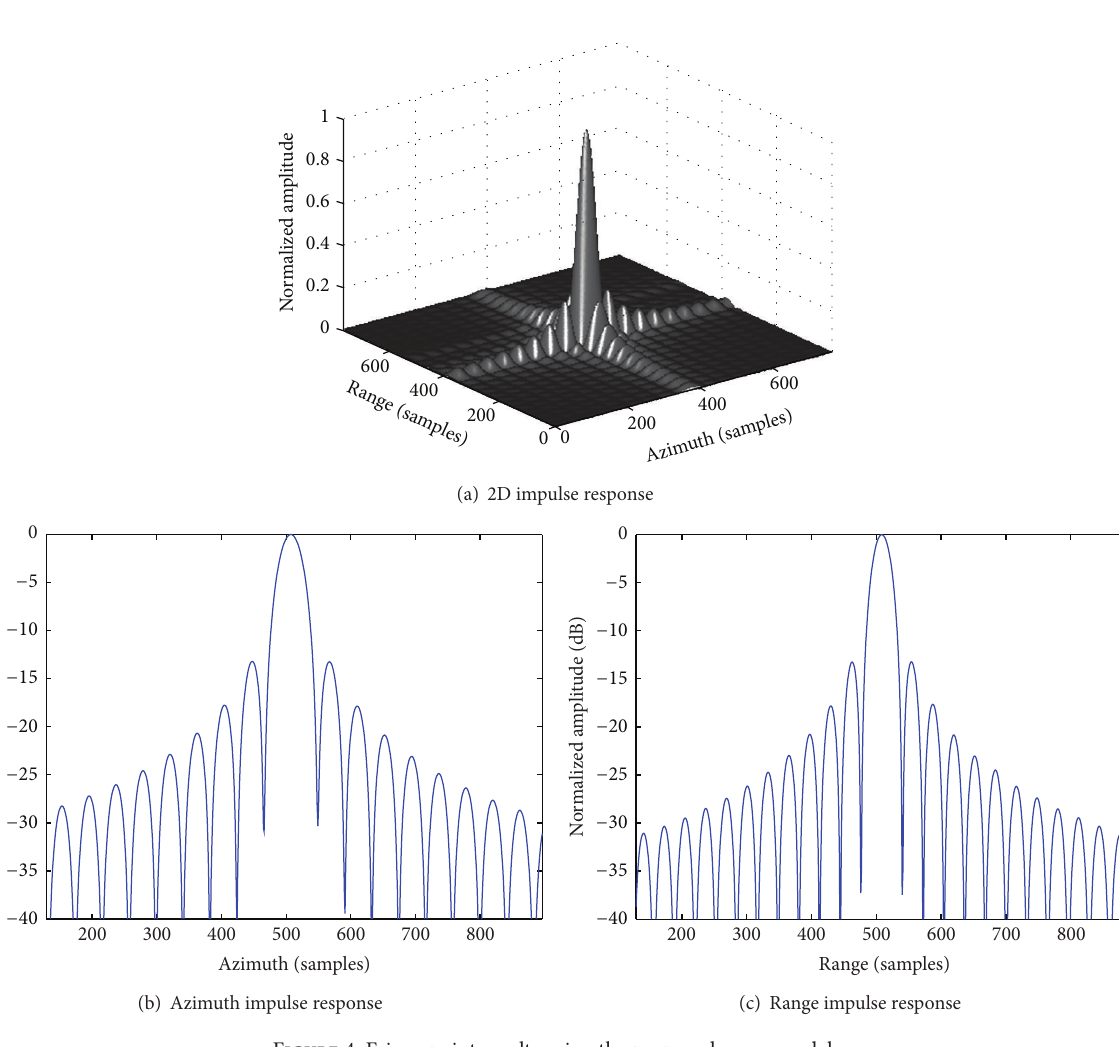
Figure 4: Fringe point results using the proposed range model.